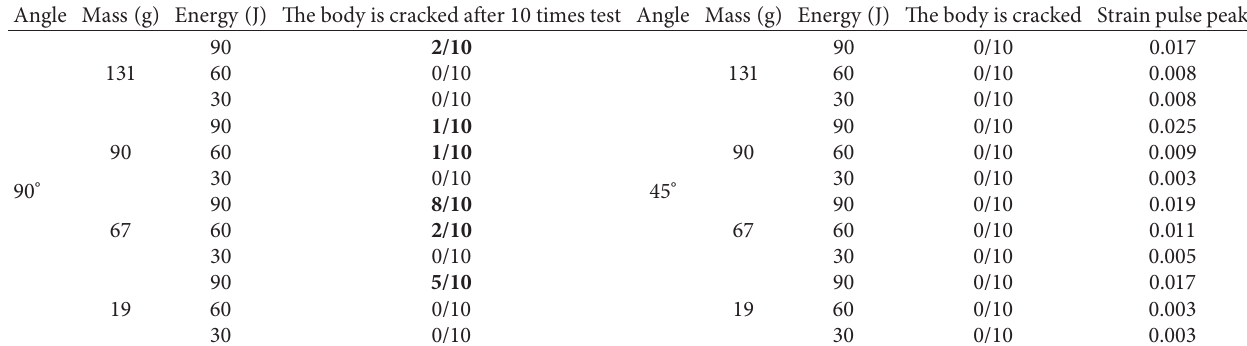
Table 2: Test results